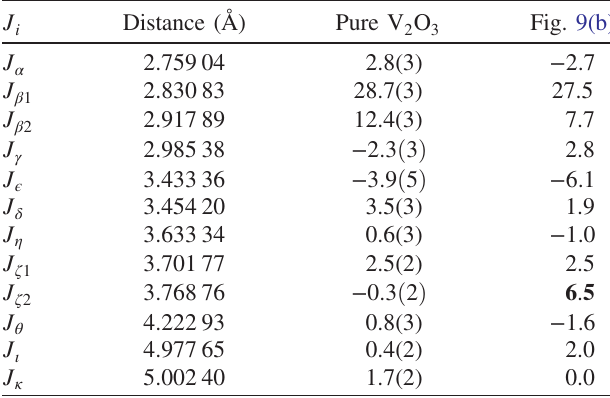
TABLE III. Exchange constants for monoclinic pure V 2 O 3 (in meV) calculated with DFT using two unit cells as explained in the text below. The resultant INS cross sections from the spin waves with these exchange constants are shown in Fig. 9(a). Also, shown in Fig. 9(b) is the LSWT result using the set of DFT calculated exchange parameters from Table I for ð V 0 with adjustments made (as described in the text) within statistical error tolerances, except for J ζ 2 (shown in bold). J ζ 2 must be increased to 6.5 meV, which is outside of the statistical error